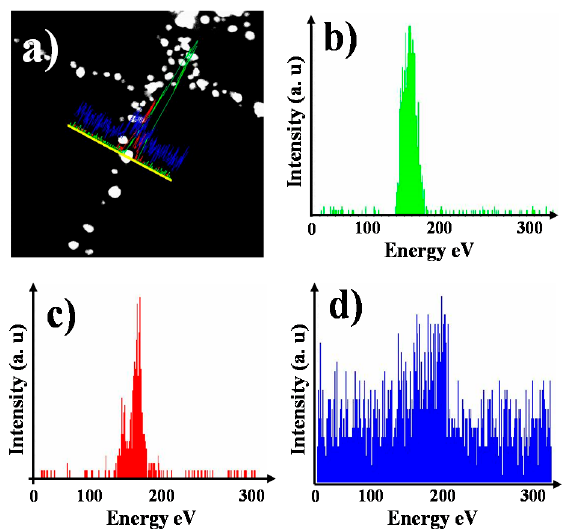
Figure 4. TEM EDX studies of Cr 2 Ni 3 nanoparticles at carbon nanofibers (NPs@CNFs); STEM image, ( a ); Ni distribution, ( b ); Cr distribution, ( c ); and C distribution, ( d ). ( a ); Ni distribution, ( b ); Cr distribution, ( c ); and C distribution, ( d